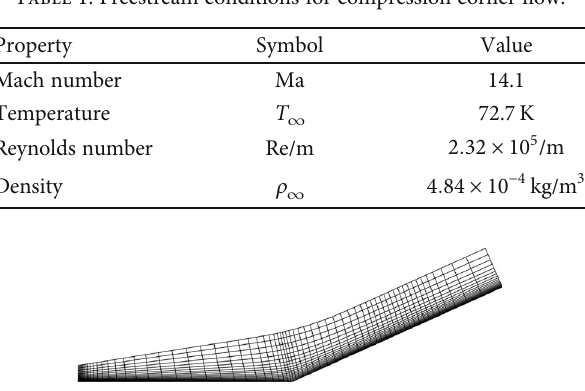
Table 1: Freestream conditions for compression corner fl ow.